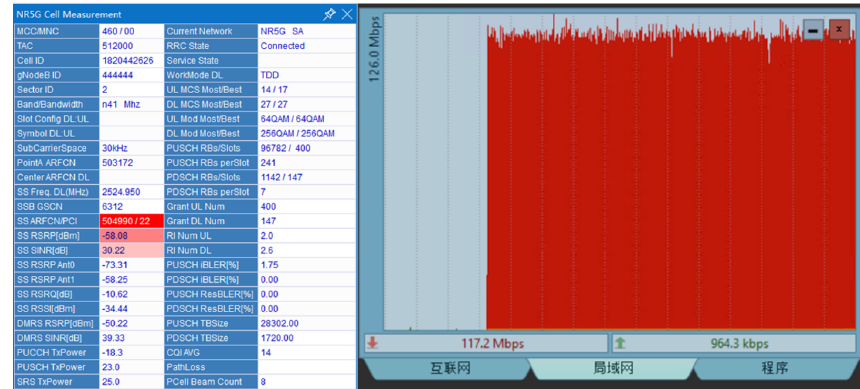
Figure 8. The system upload data rate performance.